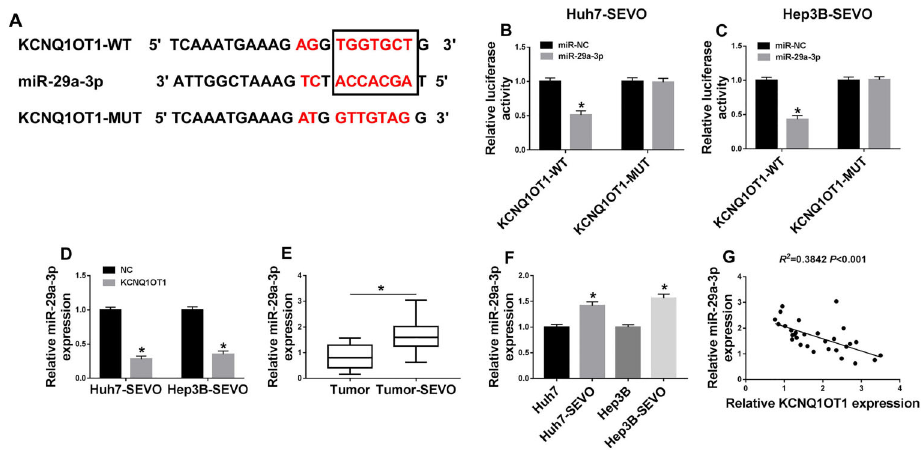
Figure 3. A , The interaction between KCNQ1OT1 and miR-29a-3p was predicted by online tool Starbase. B and C , Huh7 and Hep3B cells were treated with sevo fl urane (SEVO) for 48 h. The luciferase activity of Huh7-SEVO and Hep3B-SEVO cells transfected with KCNQ1OT1-WT (wild-type) or KCNQ1OT1-MUT (mutant) and miR-29a-3p or miR-NC (negative control) was determined (n=3). D , miR- 29a-3p level was detected by qRT-PCR assay in Huh7-SEVO and Hep3B-SEVO cells transfected with NC or KCNQ1OT1 (n=3). E , miR- 29a-3p level was measured in hepatocellular carcinoma (HCC) tumor tissues (n=30) and SEVO-treated HCC tumor tissues (n=30). F , miR-29a-3p level was detected by qRT-PCR in Huh7 and Hep3B cells, as well as Huh7-SEVO and Hep3B-SEVO cells (n=3). G , The relationship between KCNQ1OT1 level and miR-29a-3p level was explored. Data are reported as means ± SD. *P o 0.05 (Student ’ s t -test or